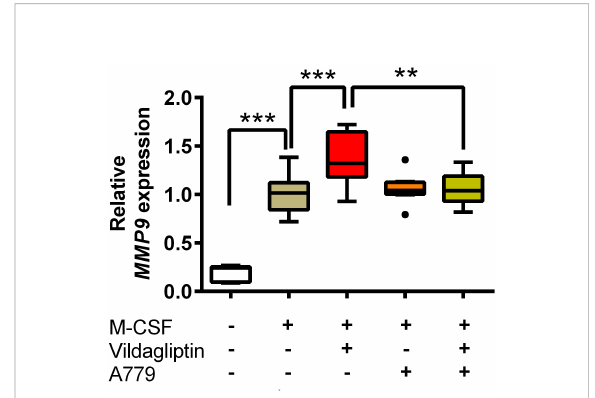
FIGURE 5 MasR inhibitor inhibited the upregulation of MMP9 induced by DPP4 inhibitors. Monocytes isolated from hPBMCs were treated with M-CSF and the indicated compounds for seven days. The concentration of vildagliptin and A779 was 10 m mol/L. The expression of MMP9 was measured from three donors with three to six replicates for each donor and was normalized to GAPDH. Data are relative to the M-CSF group at a concentration of 1. Boxes indicate the 25th and 75th percentiles; lines inside the boxes indicate medians, and whiskers indicate the upper and lower adjacent values (3/2-fold the interquartile range from the end of the box) as per Tukey ’ s test. Dots represent outliers beyond the whiskers ’ range ** p < 0.01; *** p <